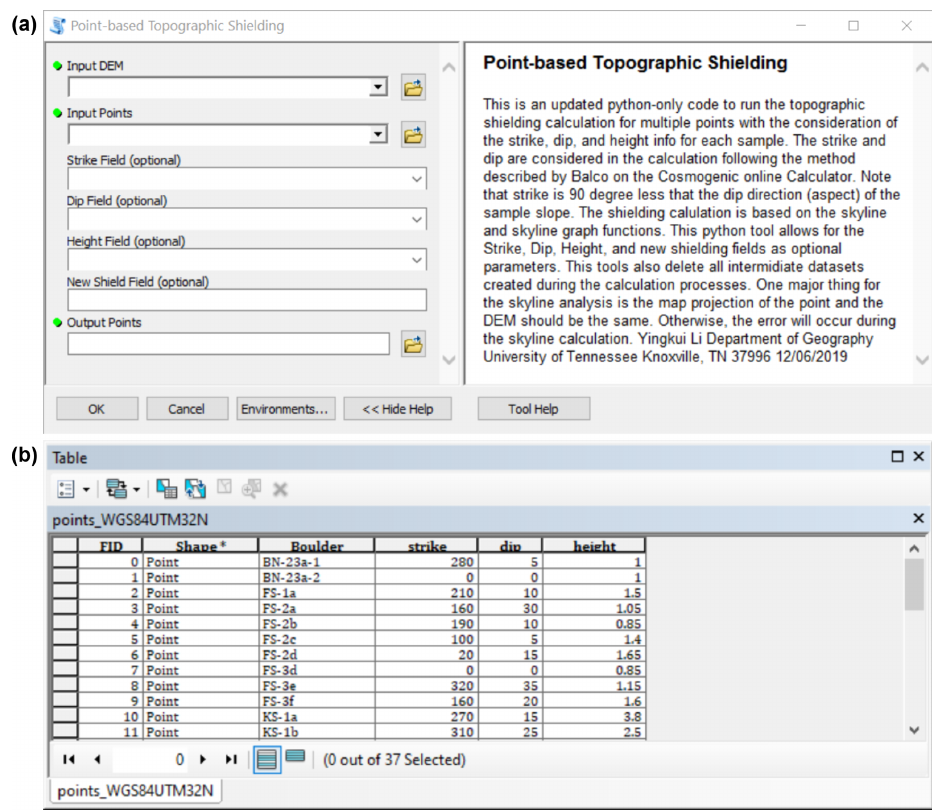
Figure A1. Workflow of toolbox of Li (2018) in the ESRI ® ArcGIS software (Environmental Systems Research Institute, 2020). (a) Screen- shot of the graphical interface of the toolbox. The toolbox requires at least a DEM (raster) and a point file of the sampling sites, such as a shapefile. The name of the field in the attribute table with the shielding factors can be specified before running the tool. Strike and dip of the sampled surfaces in degrees and the height above ground of the sampling surfaces in metres need to be inserted in the attribute table of the input points if one wants to correct the shielding factors for these variables. (b) Example of an attribute table of a point file for shielding factor